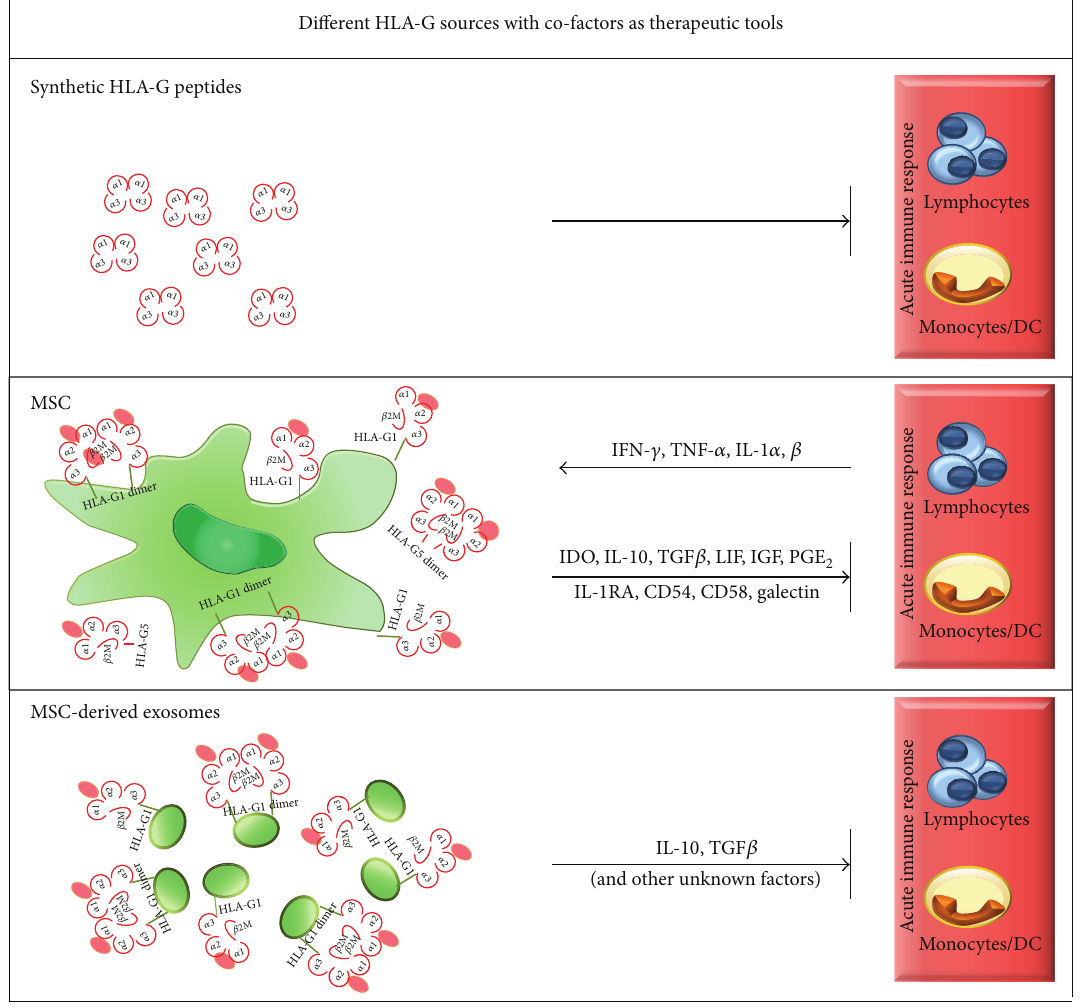
Figure 2: Different HLA-G sources as therapeutic tools. Either synthetic HLA-G peptides or HLA-G positive mesenchymal stem cells (MSC) and MSC-derived exosomes can be used as source to suppress acute immune response of lymphocytes and monocytes/dendritic cells (DC).